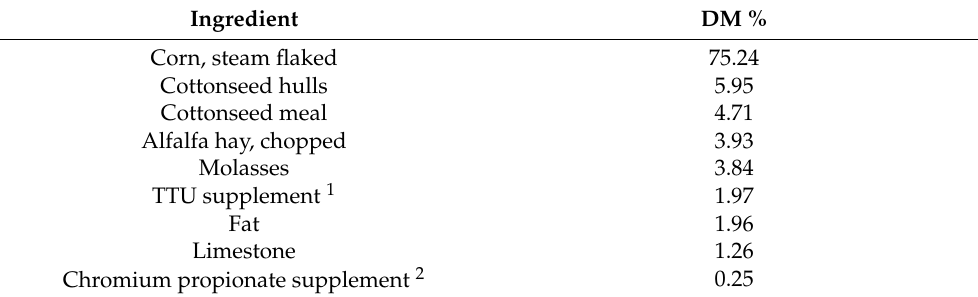
Table 1. Ingredient composition of experimental diet (%, dry matter [DM]